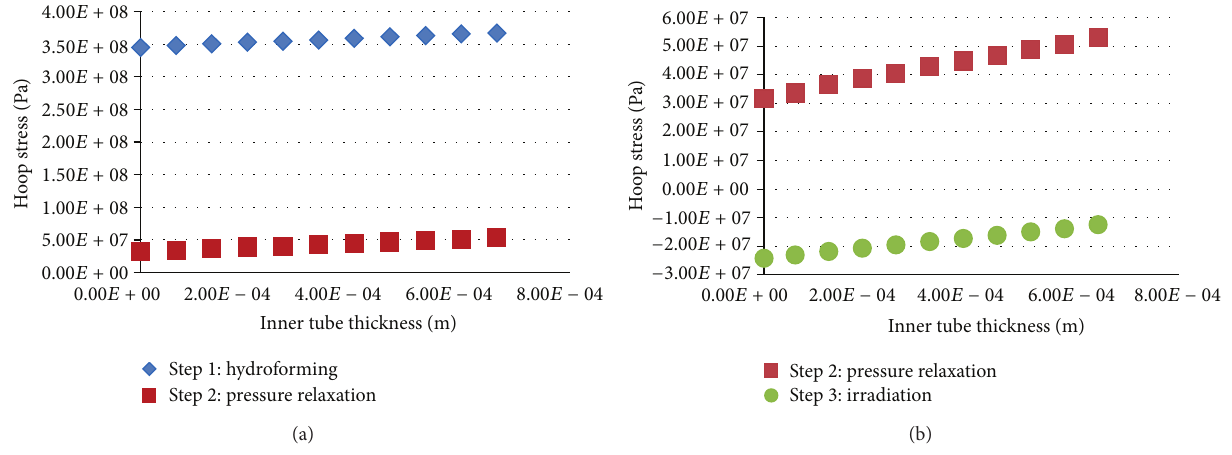
Figure 12: Hoop stress distribution in the inner tube through various modeling steps at 𝜃 = 270 ∘